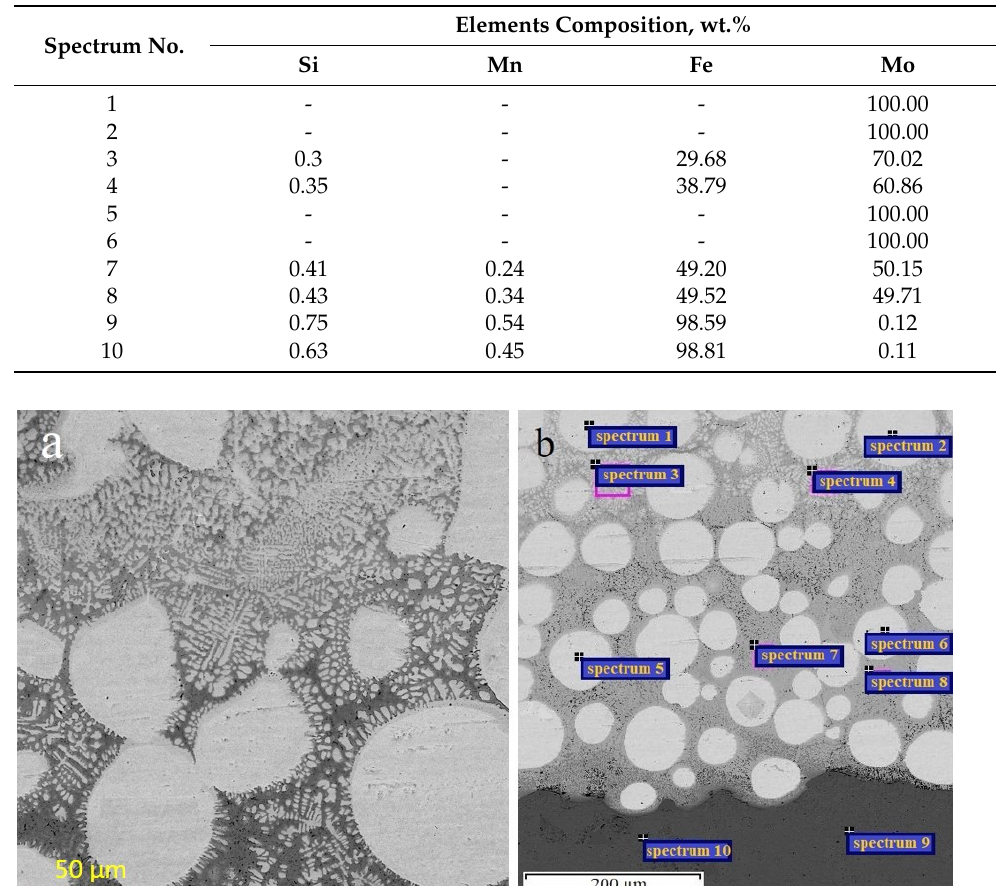
Table 6. Single EDX spectrum analysis in the Mo–steel boundary area (Figure 11b).